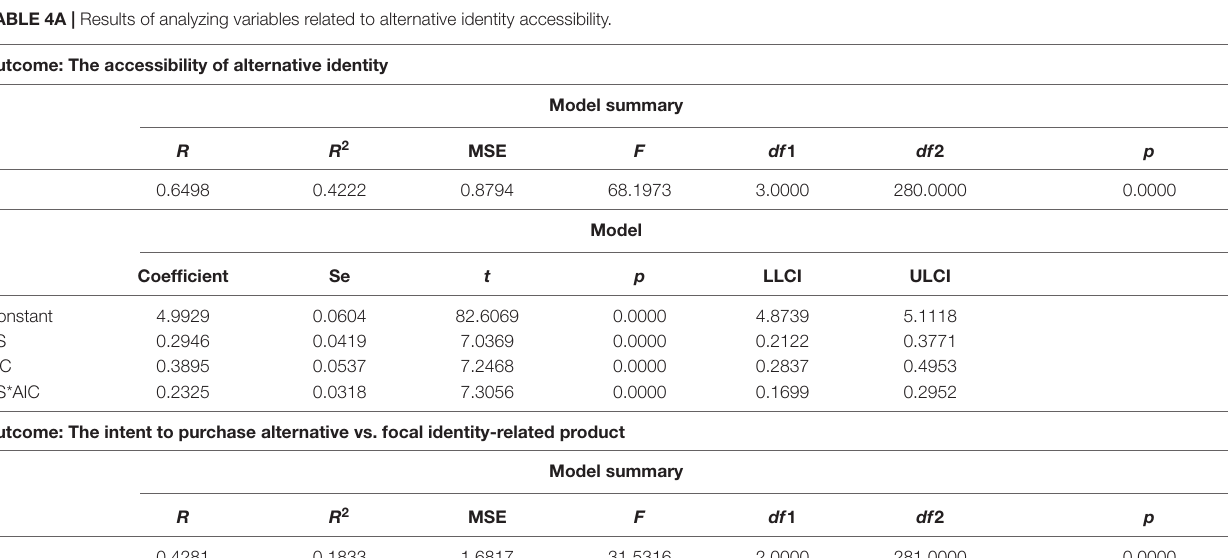
TABLE 4A | Results of analyzing variables related to alternative identity